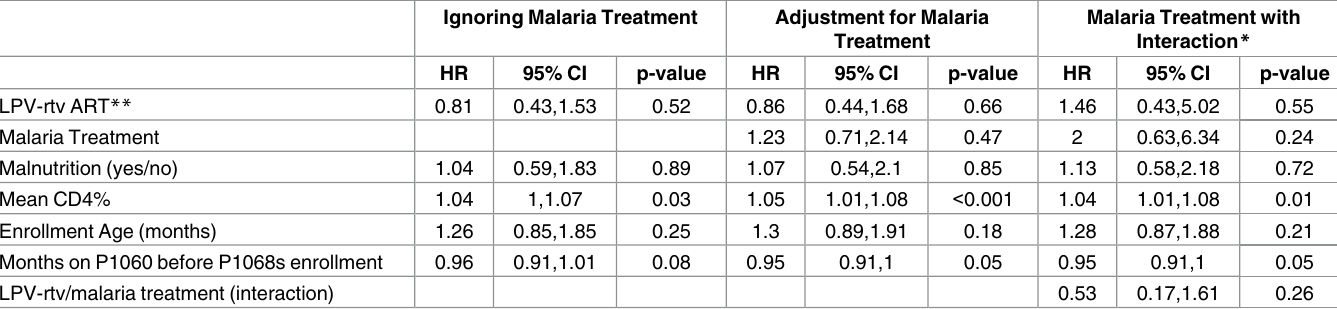
Table 3. As Treated Recurrent Events of Confirmed Clinical Malaria (CCM) (Cox